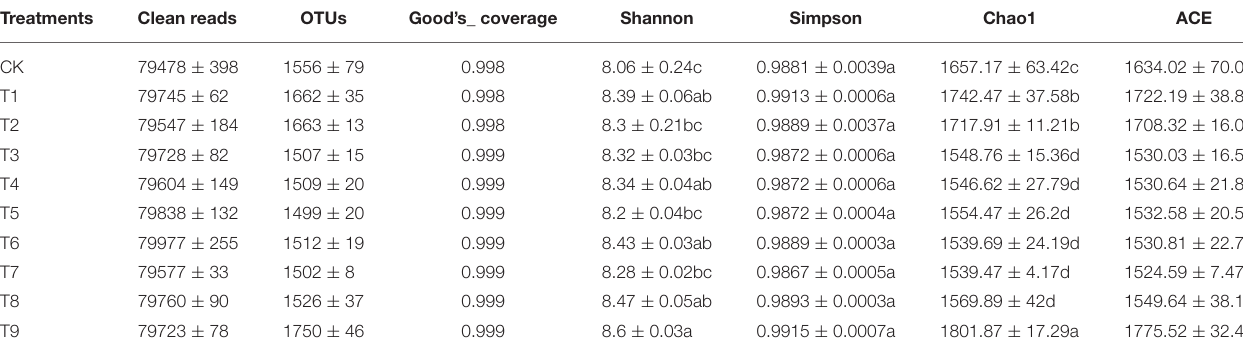
TABLE 3 | High-throughput sequencing results and α -diversity indexes of fungal communities in ginseng rhizosphere soil samples. Treatments Clean